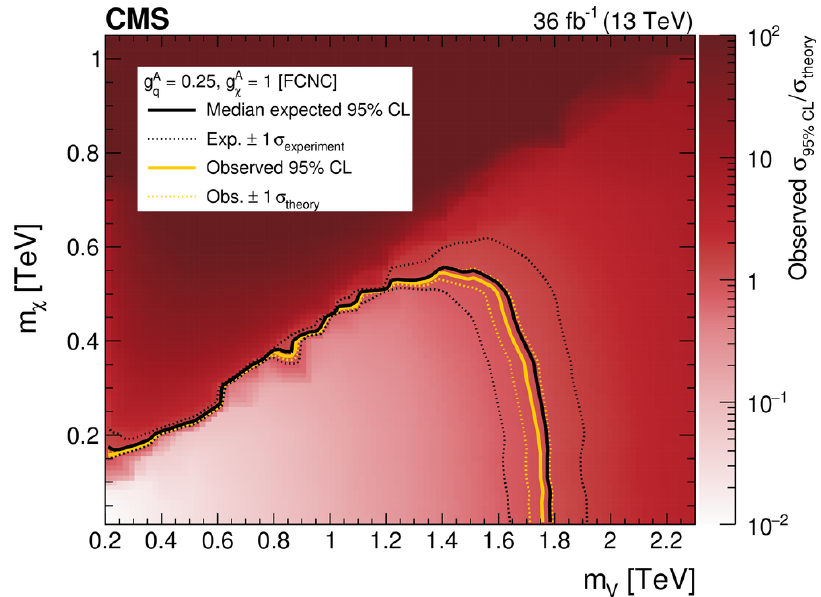
Figure 10 . Results for the FCNC interpretation presented in the two-dimensional plane spanned by the mediator and DM masses. The mediator is assumed to have purely axial couplings to quarks and DM particles. The observed exclusion range (gold solid line) is shown. The gold dashed lines show the cases in which the predicted cross section is shifted by the assigned theoretical uncertainty. The expected exclusion range is indicated by a black solid line, demonstrating the search sensitivity of the analysis. The experimental uncertainties are shown in black dashed